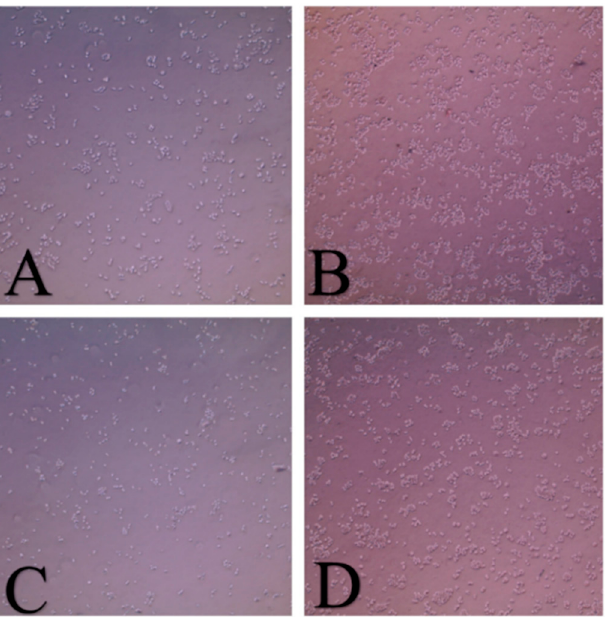
Figure 5. Cell culture in RPMI medium with and without addition of FBS for 72 h; A ) DU-145 in FBS-free medium; ( B ) DU-145 in RPMI with 10% FBS; ( C ) PC3 in FBS-free medium; and ( D ) PC3 in FBS-free medium; B ) DU-145 in RPMI with 10% FBS; C ) PC3 in FBS-free medium; and D ) PC3 in FBS-containing medium. FBS-containing